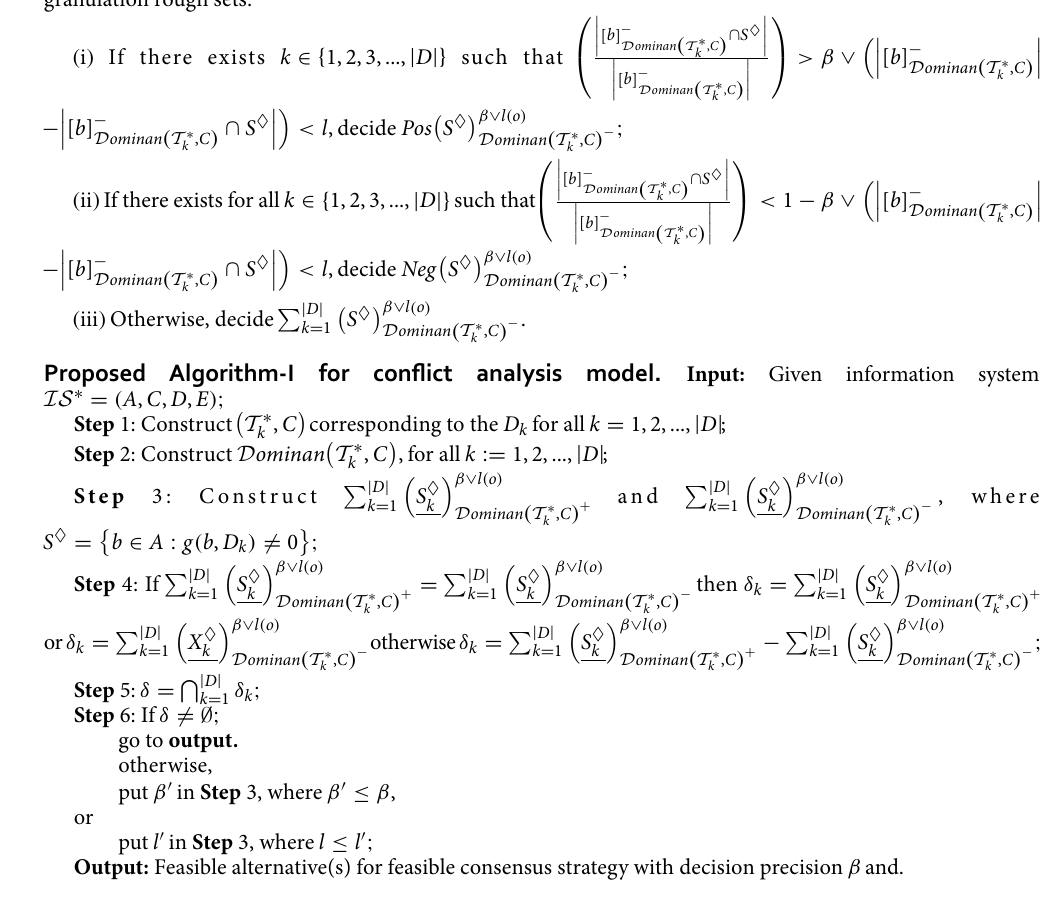
C ) and Dominated classes 2 ,